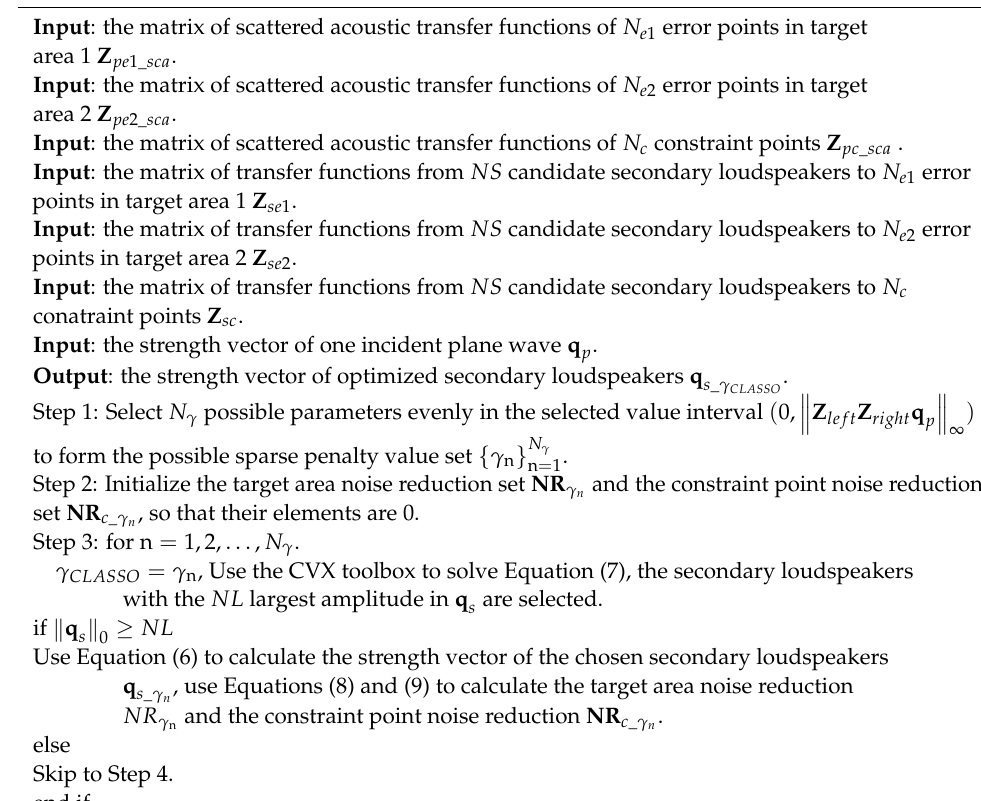
Algorithm 1. The CLASSO-RLS